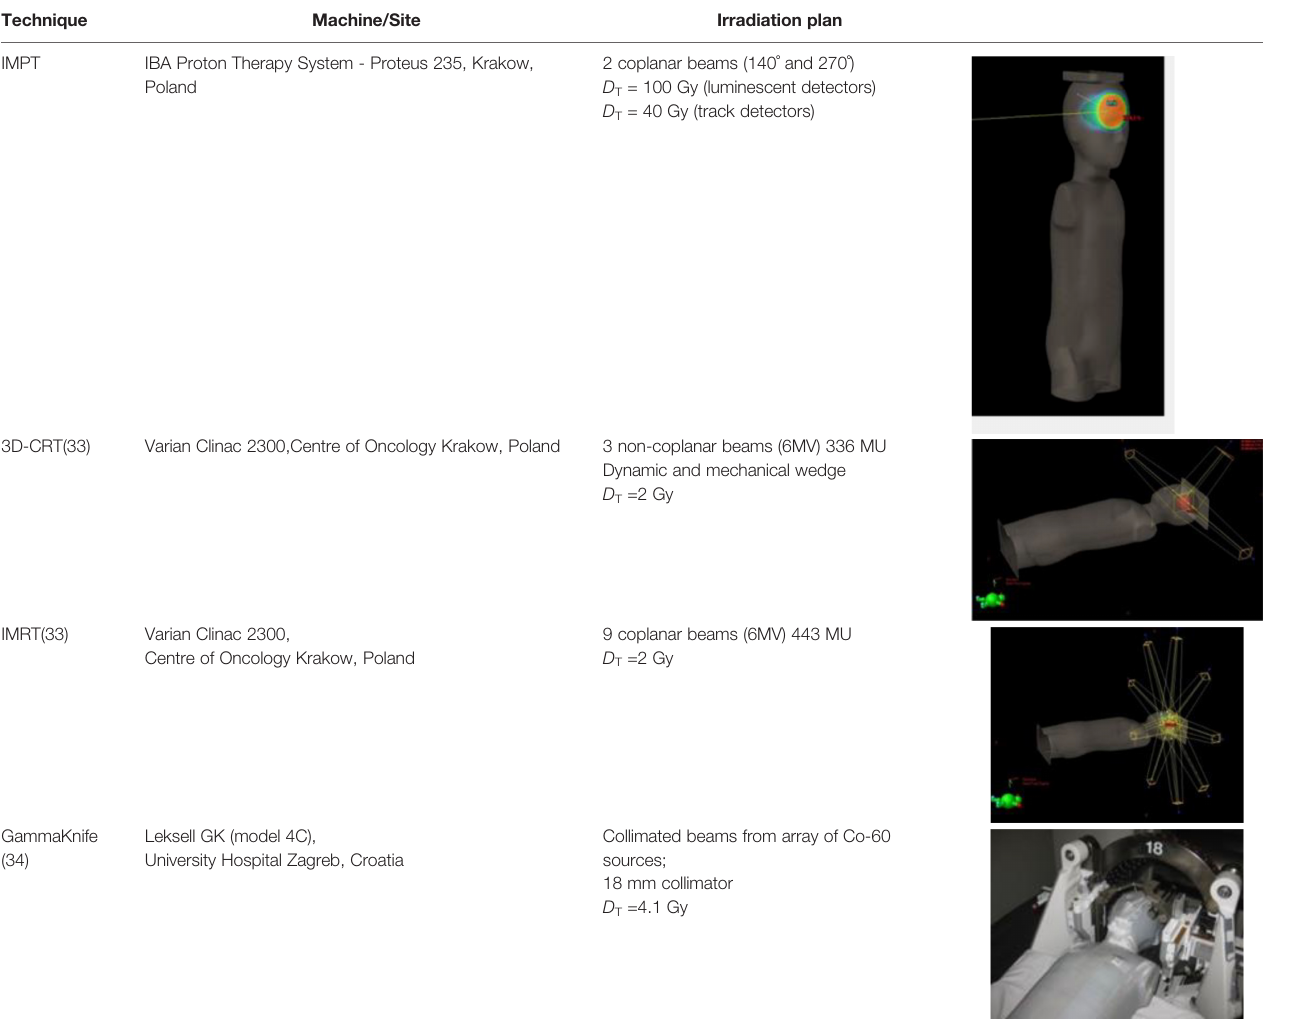
TABLE 2 | Details of irradiation set-up for different RT techniques investigated by Eurados WG9. Technique